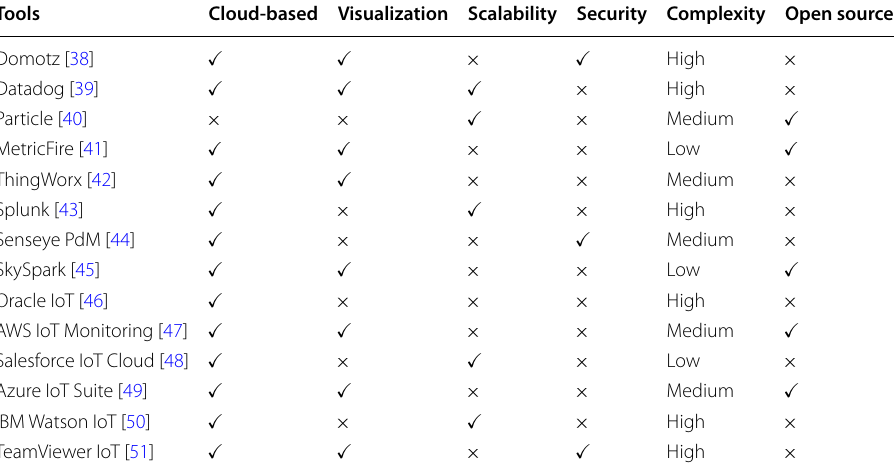
Table 1 List of available centralized/remote IoT device monitoring tools